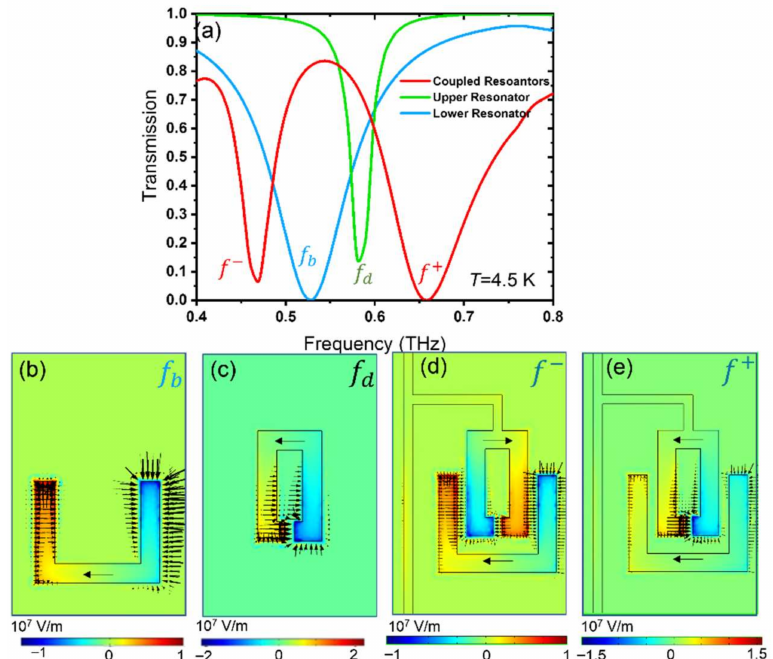
Figure 2. ( a ) Simulated THz transmission of static superconducting Nb SRR arrays in the absence of graphene. Transmission curves when only a bottom ring structure (blue), when only a top ring structure (green), and when two coupled ring resonators (red) are used at T = 4.5 K. ( b – e ) The z -component of the electric field E z and surface current distribution at relevant resonance frequencies, shown in ( a